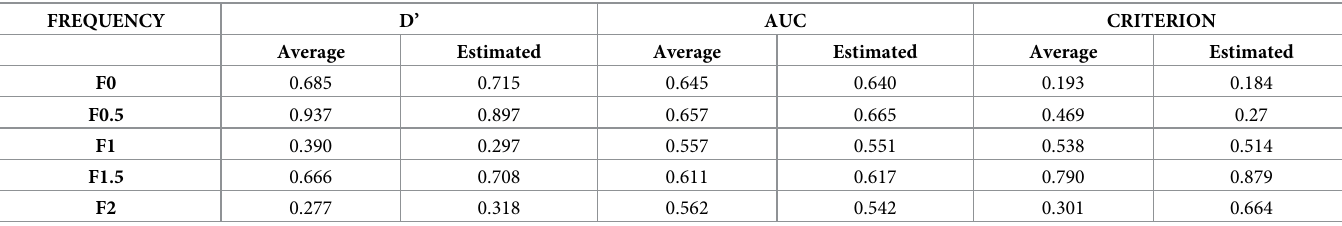
Table 2. Group average and mixed model estimated mean of of D’, criterion, and AUC for unfiltered mammograms and each high-pass filter frequency. FREQUENCY D’ AUC CRITERION Average Estimated Average Estimated Average